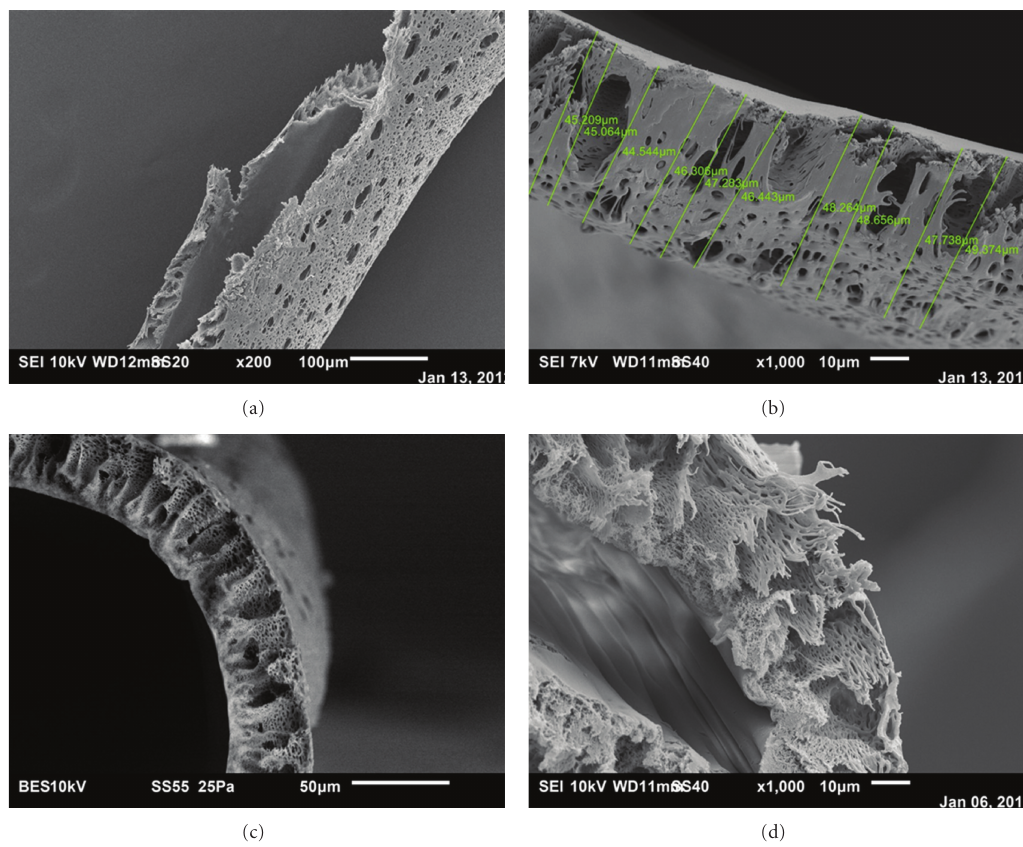
Figure 3: (a) Dissected Polyflux capillary showing the morphologies of the outer and inner surfaces at 200x, (b) capillary wall thickness of Polyflux 210H at 1000x with measurements. (c) Cross section of Polyflux 210H illustrating the radial supporting structure that extends from the inner skin layer of the capillary to the outside surface. (d) Cross section of Polyflux 210H at 1000x illustrating the radial variation in compactness in the capillary’s